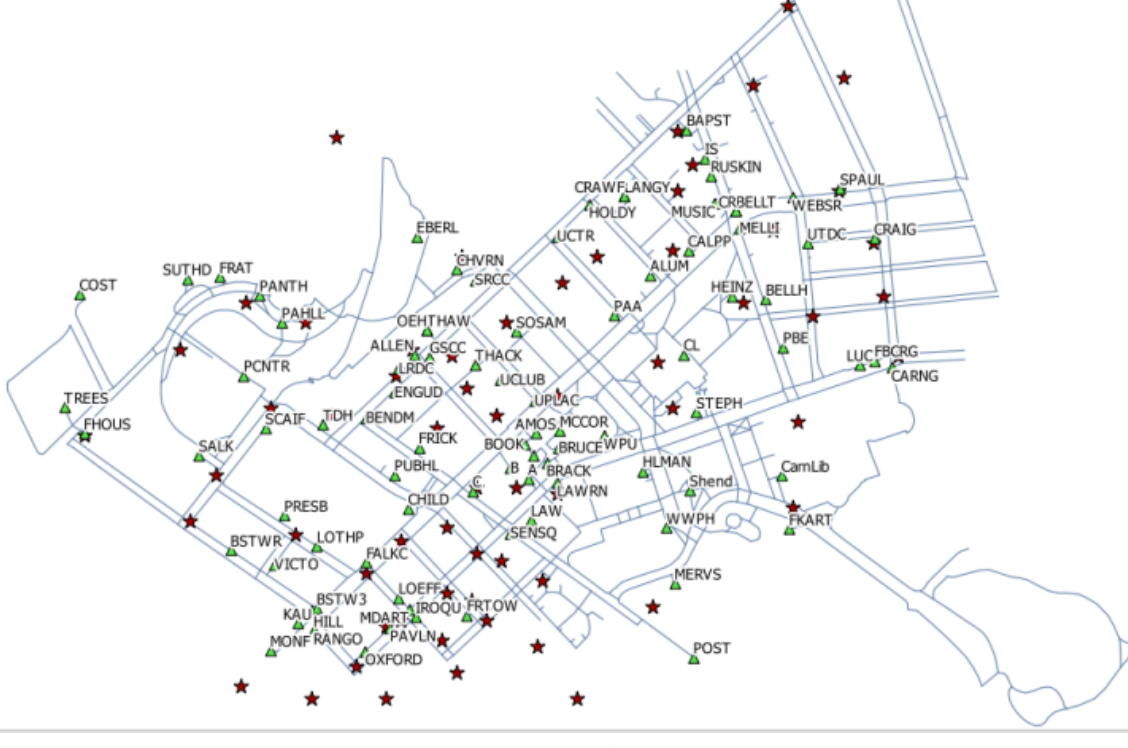
Figure 3. A map of the accessible sidewalk network of the University of Pittsburgh’s main campus.